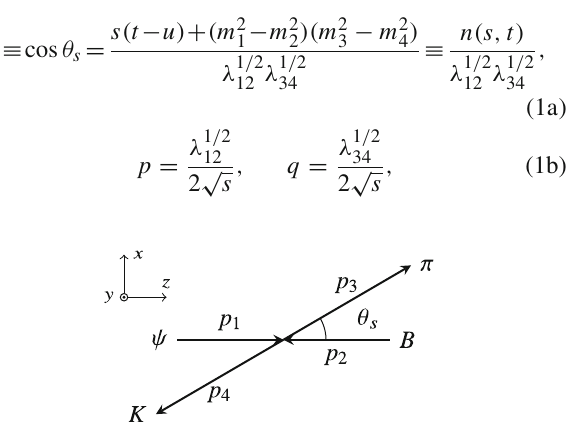
Fig. 2 Scattering kinematics in the s -channel rest frame. In the decay kinematics, the momentum and the spin of the ψ is reversed, so to keep the same